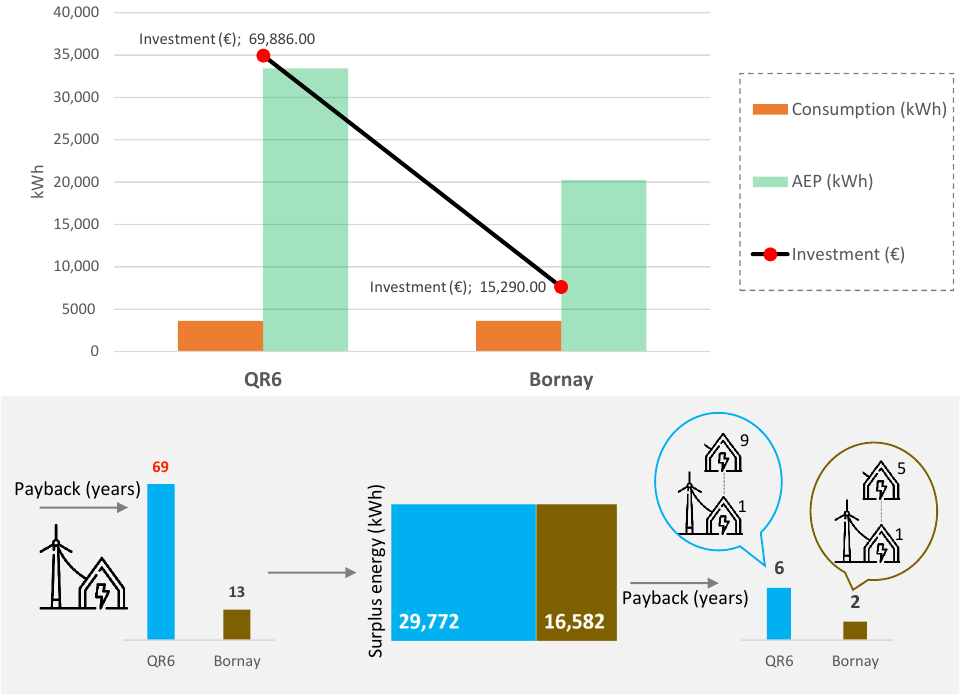
Figure 10. AEP (kWh/year), investment, payback, and surplus energy (‘alone near buildings’ typol- ogy for different number of houses —1 to 5, and 1 to 9). Authors’ own